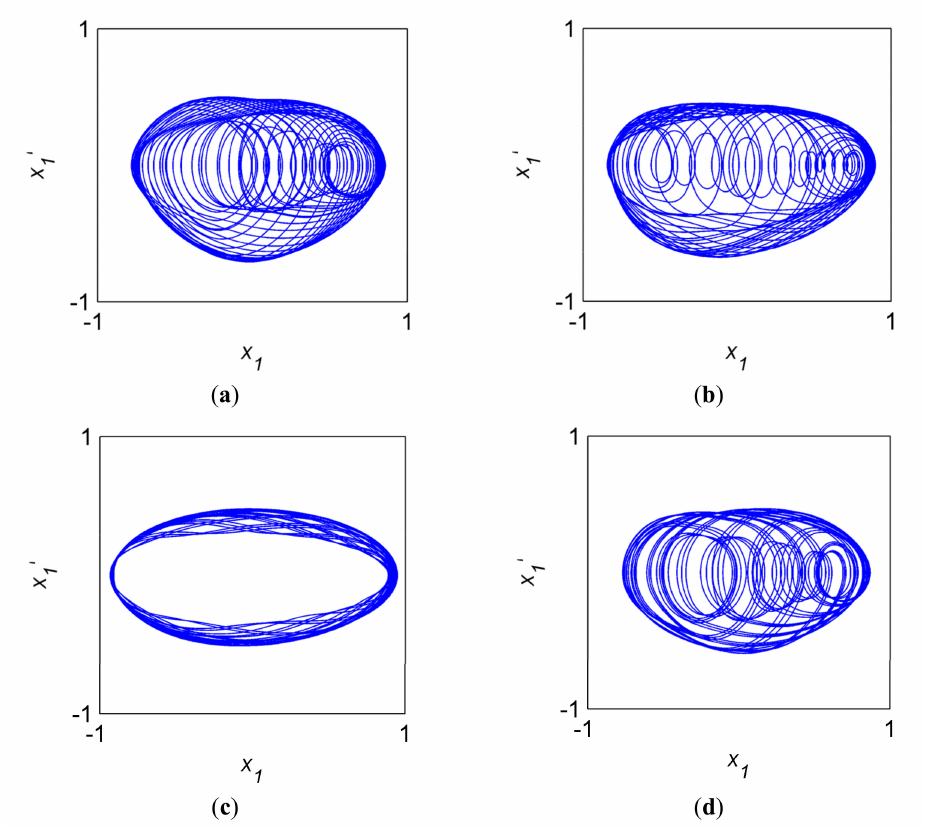
Figure 13. The phase portraits of o 1 when ω = 1020 rad/s. ( a ) The oil-filmed system. ( b ) The cracked system. ( c ) The rub-impacted system. ( d ) The coupled